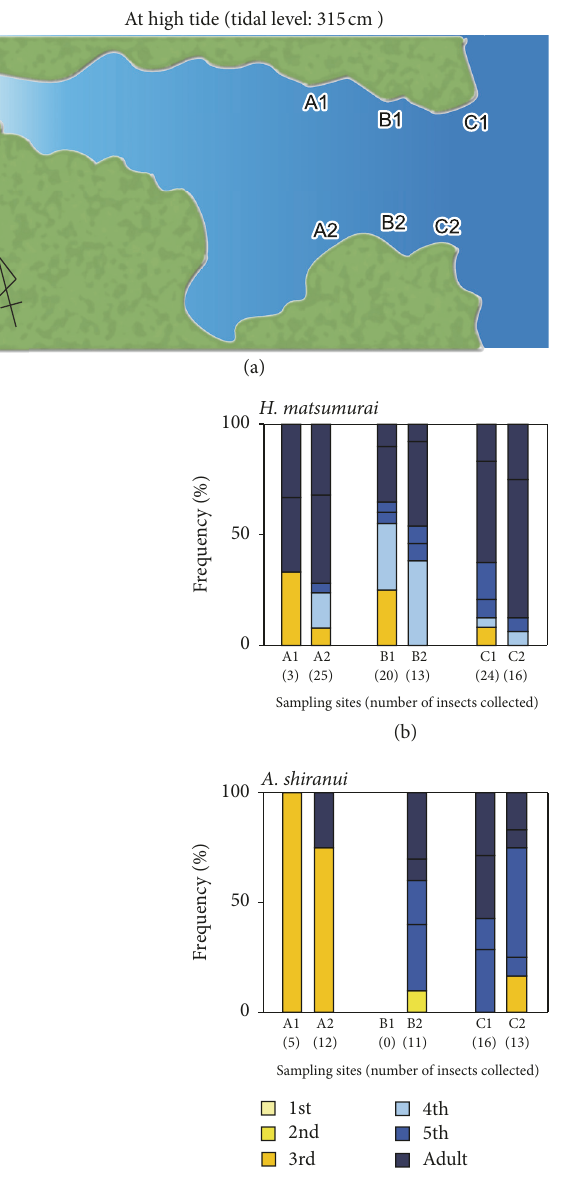
Figure 3: (a) Sampling sites (A1, A2, B1, B2, C1, and C2) at high tide. (b) Composition of developmental stages of H. matsumurai and (c) of A. shiranui at each sampling